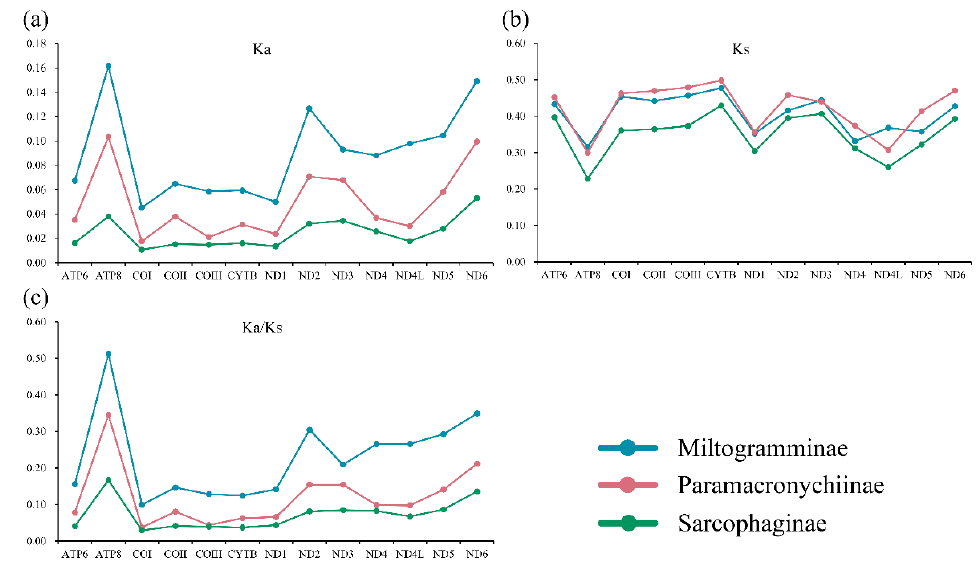
Figure 3. Synonymous (Ka; ( a )) and nonsynonymous (Ks; ( b )) substitutional rates and the Ka/Ks ratios ( c ) of the 13 protein-coding genes of the three subfamilies of Sarcophagidae. Furthermore, the pairwise nonsynonymous (Ka) to synonymous (Ks) substitution ra- tio ( ω ) of all the PCGs in Sarcophagidae was analyzed, and the Ka/Ks ratio of ATP8 ( ω = 0.286) and ND6 ( ω = 0.203) was higher, indicating that these genes were under relatively little selection pressure (Figure 4). However, the Ka/Ks ratio of COI was the lowest ( ω = 0.051), indicating a higher selection pressure for COI than for other genes. Based on the pairwise genetic distance calculation, ND6 (0.205), ND2 (0.175), and ND3 (0.174) had the highest values, while ND1 (0.105), ND4L (0.108), and ND4 (0.126) had the lowest.